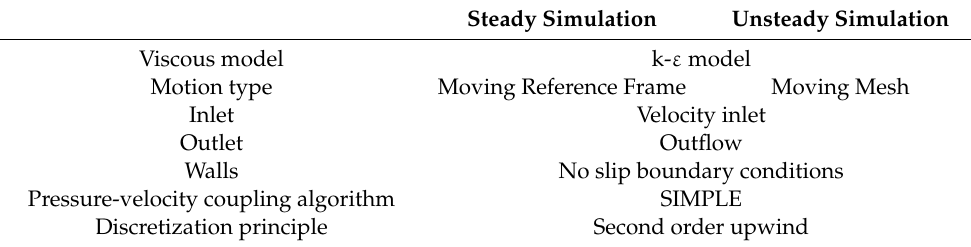
Figure 2. Sketch of the centrifugal pump mesh. Table 2. Relevant settings of Computational Fluid Dynamics